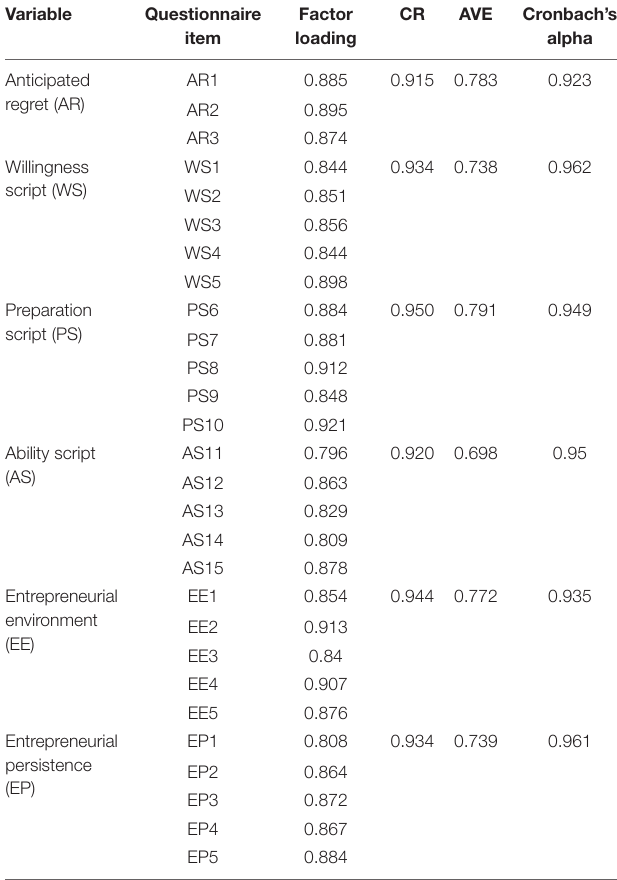
TABLE 1 | Convergent validity of the measurement model.